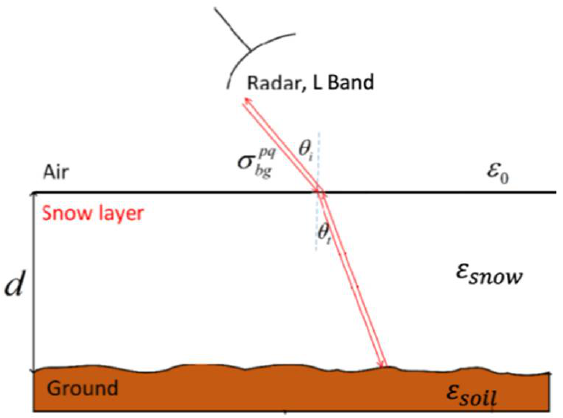
Figure 21. The interaction of radar with snow overlying a rough soil surface.